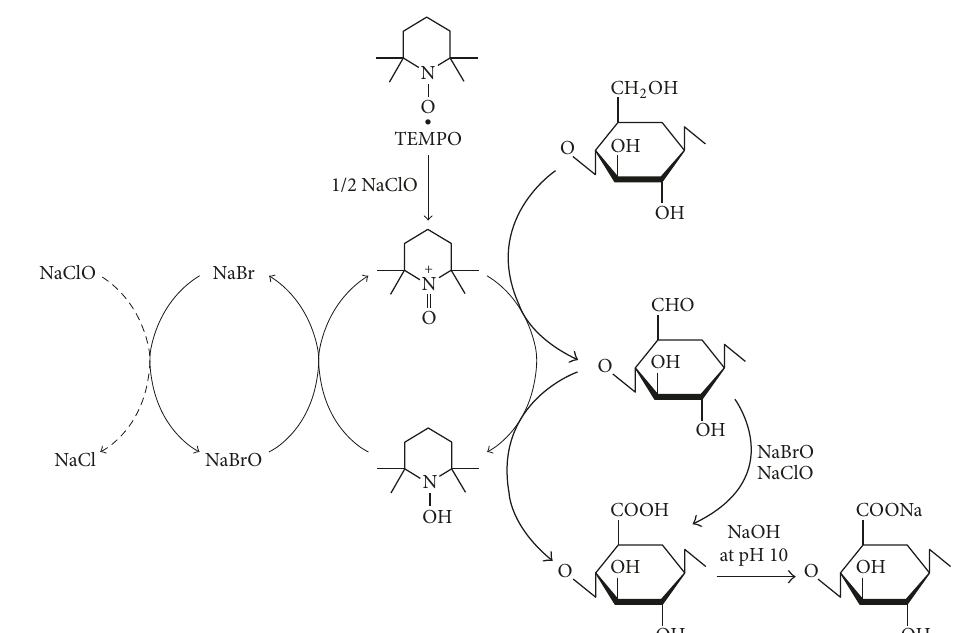
Figure 11: Regioselective oxidation of C6 primary hydroxyls of cellulose to C6 carboxylate groups by TEMPO/NaBr/NaClO system in water at pH 10-11